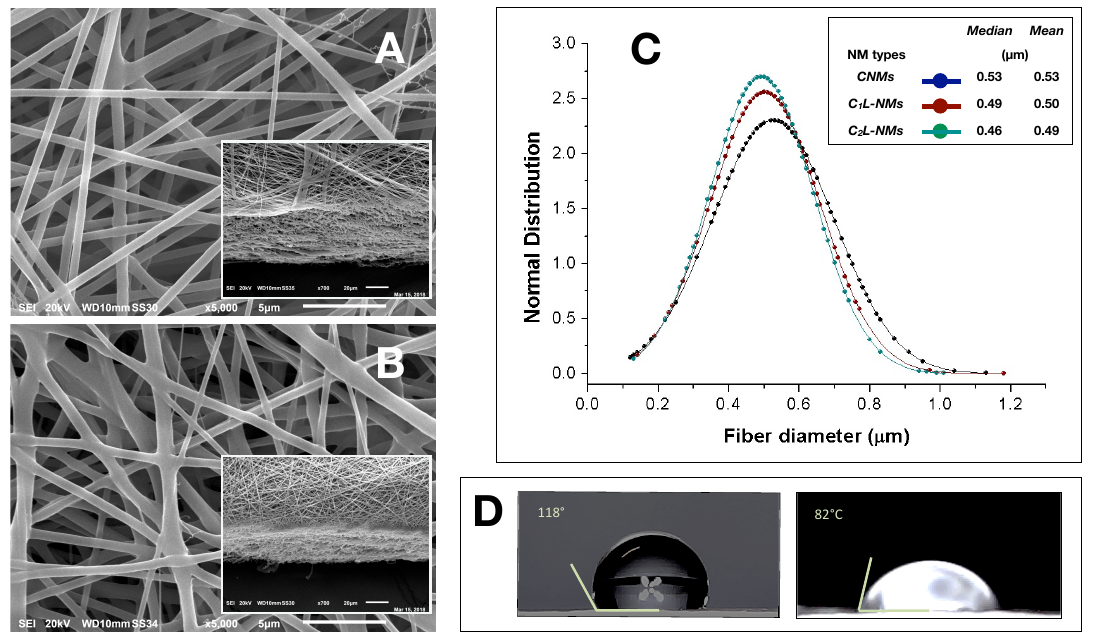
Figure 3. SEM micrographs of CNMs (control) ( A ) and C 2 L-NMs (high concentration catechol loading NMs) ( B ) before the incubation with duckweed plants (magnification × 5000)—insets: tilted cross sections of the same NMs (magnification × 700); ( C ) distribution analysis of the nanofiber diameters present in CNMs, C 1 L-NMs, and C 2 L-NMs ( n = 150); ( D ) Contact angles of CNMs (left) and C 2 L-NMs (right). Scale bars in the micrographs correspond to 5 µ m ( A , B ) and 20 µ m (relative insets).